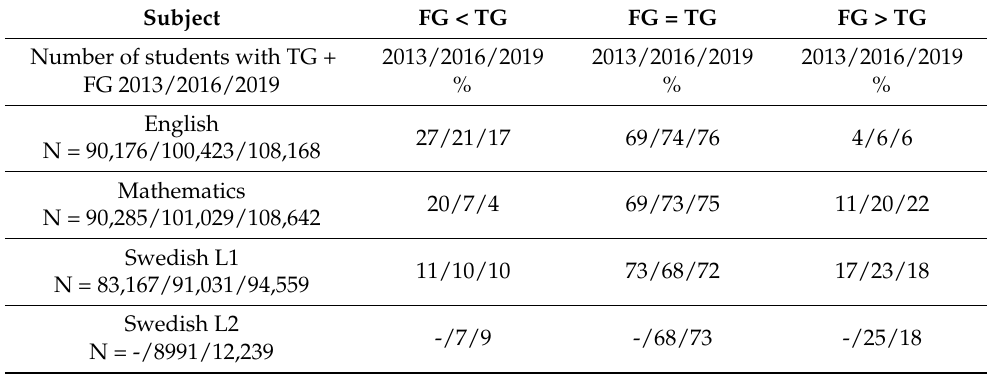
Table 1. Test grade (TG) in relation to teachers’ final grades (FG); school Year 6 (2013, 2016 and